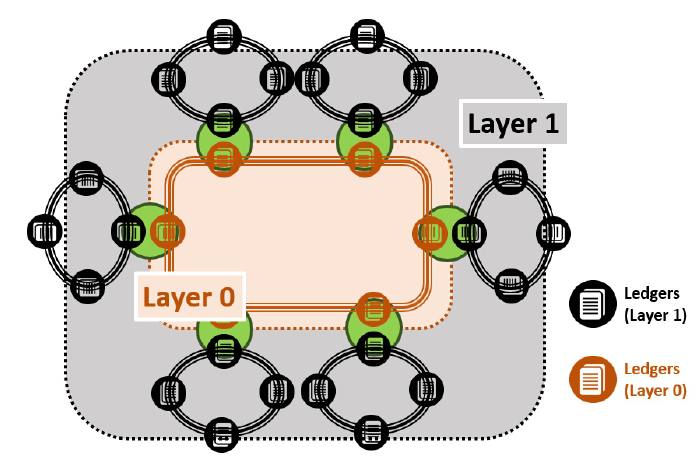
Figure 1. Multi-Layered Blockchain Governance Game